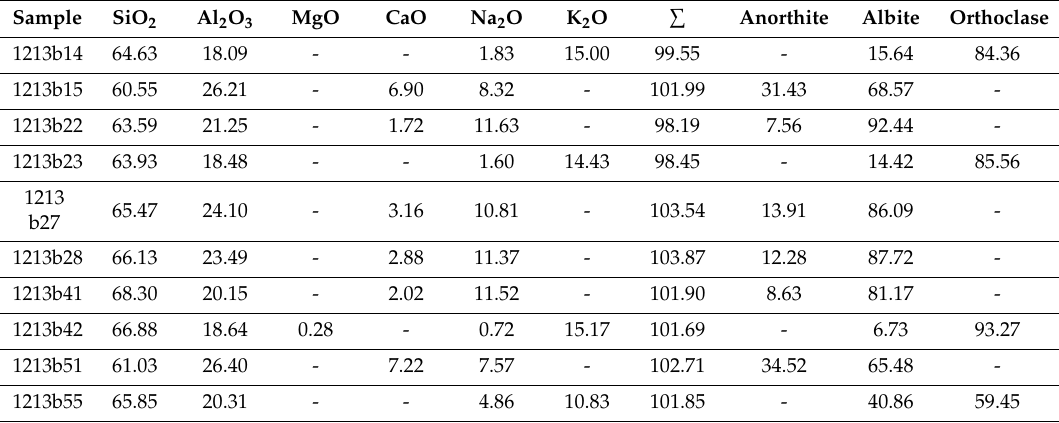
Table 1. Electron microprobe analysis of K-feldspars in granodiorite from Ergelyakh massif. Sample SiO